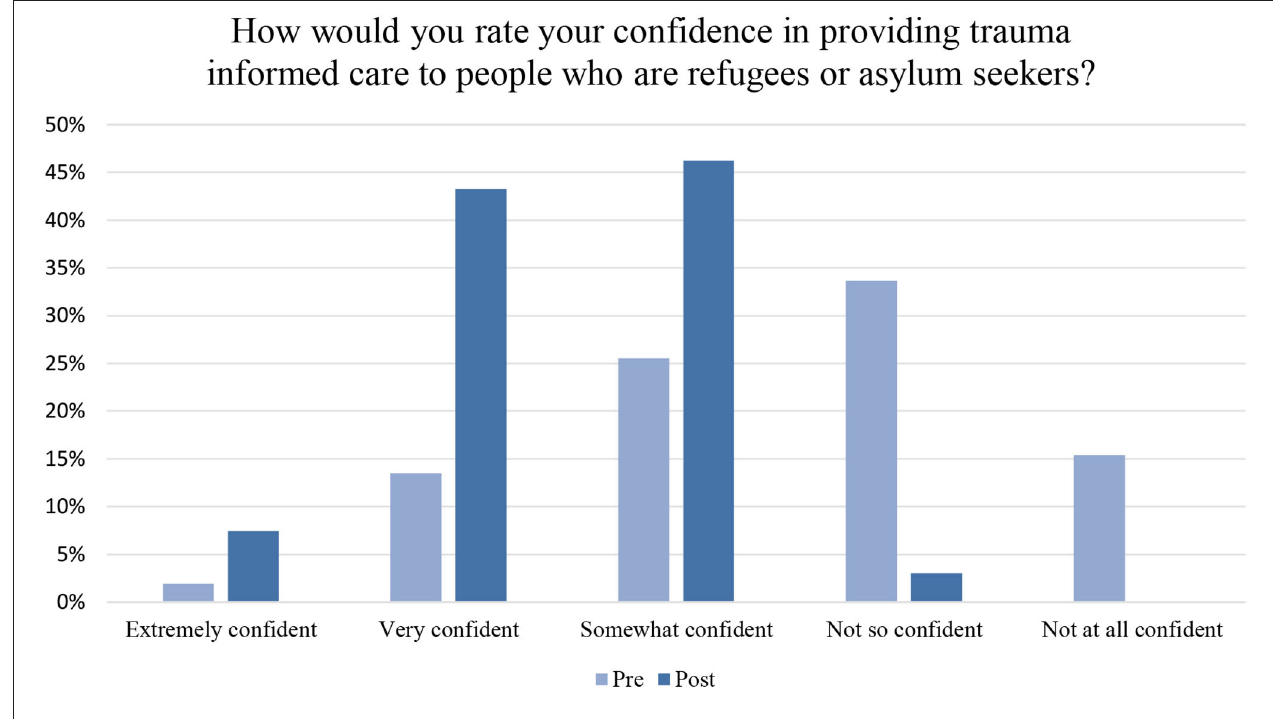
FIGURE 1 | Pre/post training survey.